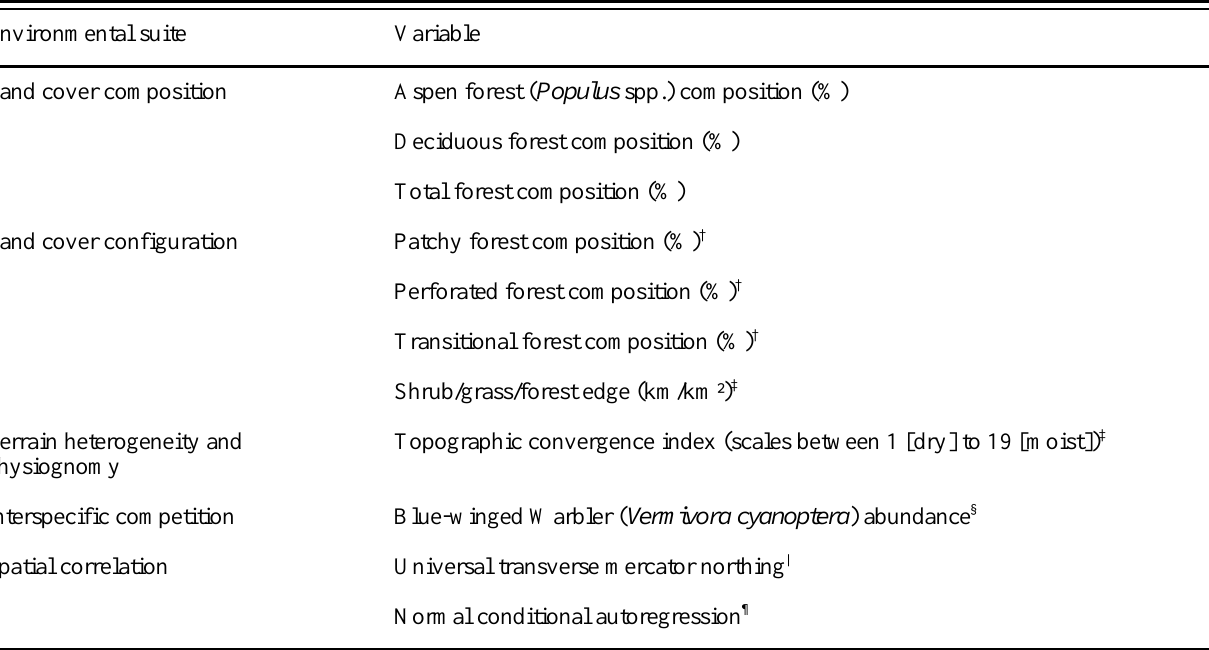
Table 1. Environmental variables included in initial (global) models of habitat associations for the Golden- winged Warbler ( Vermivora chrysoptera ) in Bird Conservation Region 23, the Prairie Hardwood